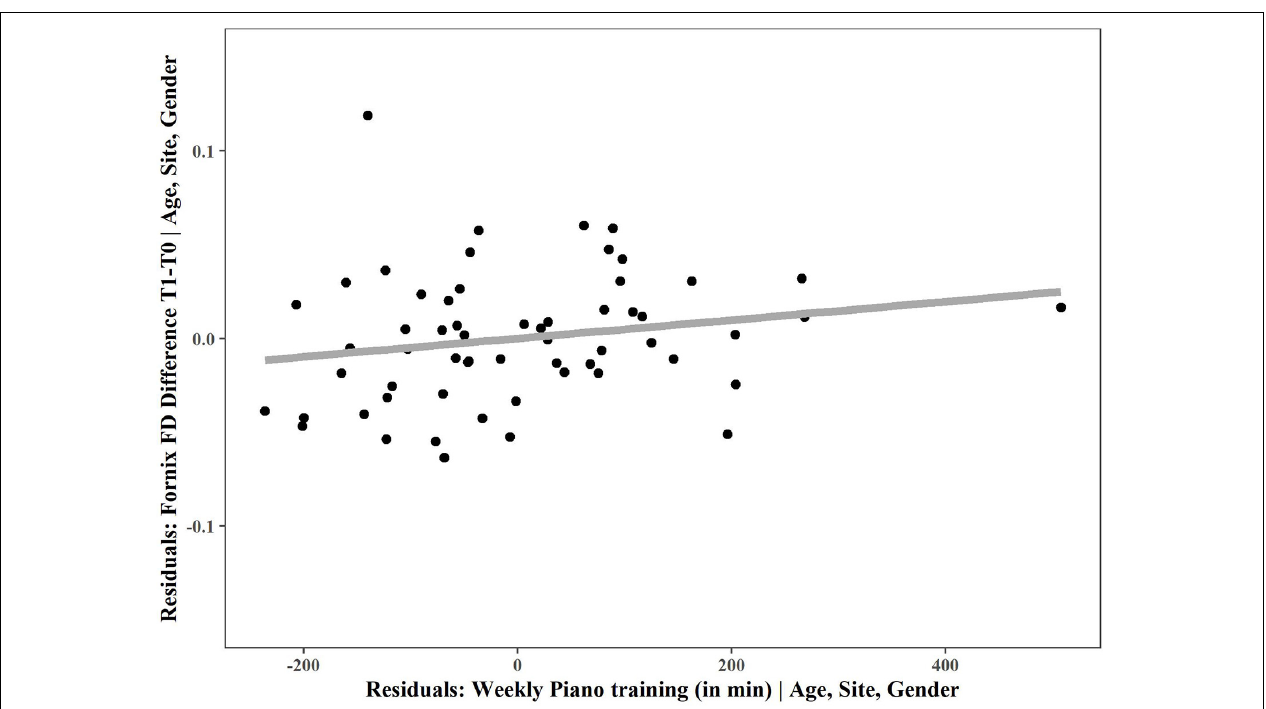
FIGURE 4 | Non-parametric partial correlation between fornix FD and weekly piano training. Non-parametric partial correlation, controlling for age (at the start of the intervention), site and gender revealed a significant correlation between fornix FD change and weekly piano training. For visualization, the residuals of multiple regression are plotted and a linear regression line was chosen to depict the positive correlation. T0, baseline measurement; T1, 6 months